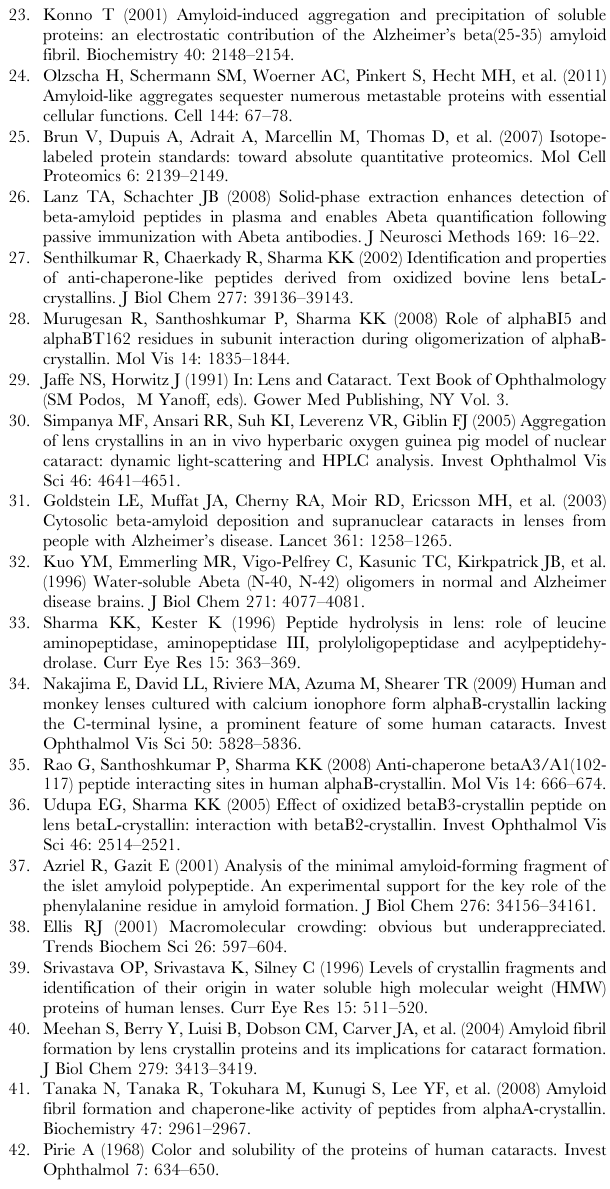
phosphate buffer (pH 7.2) at 37 u C for 24 h and then examined